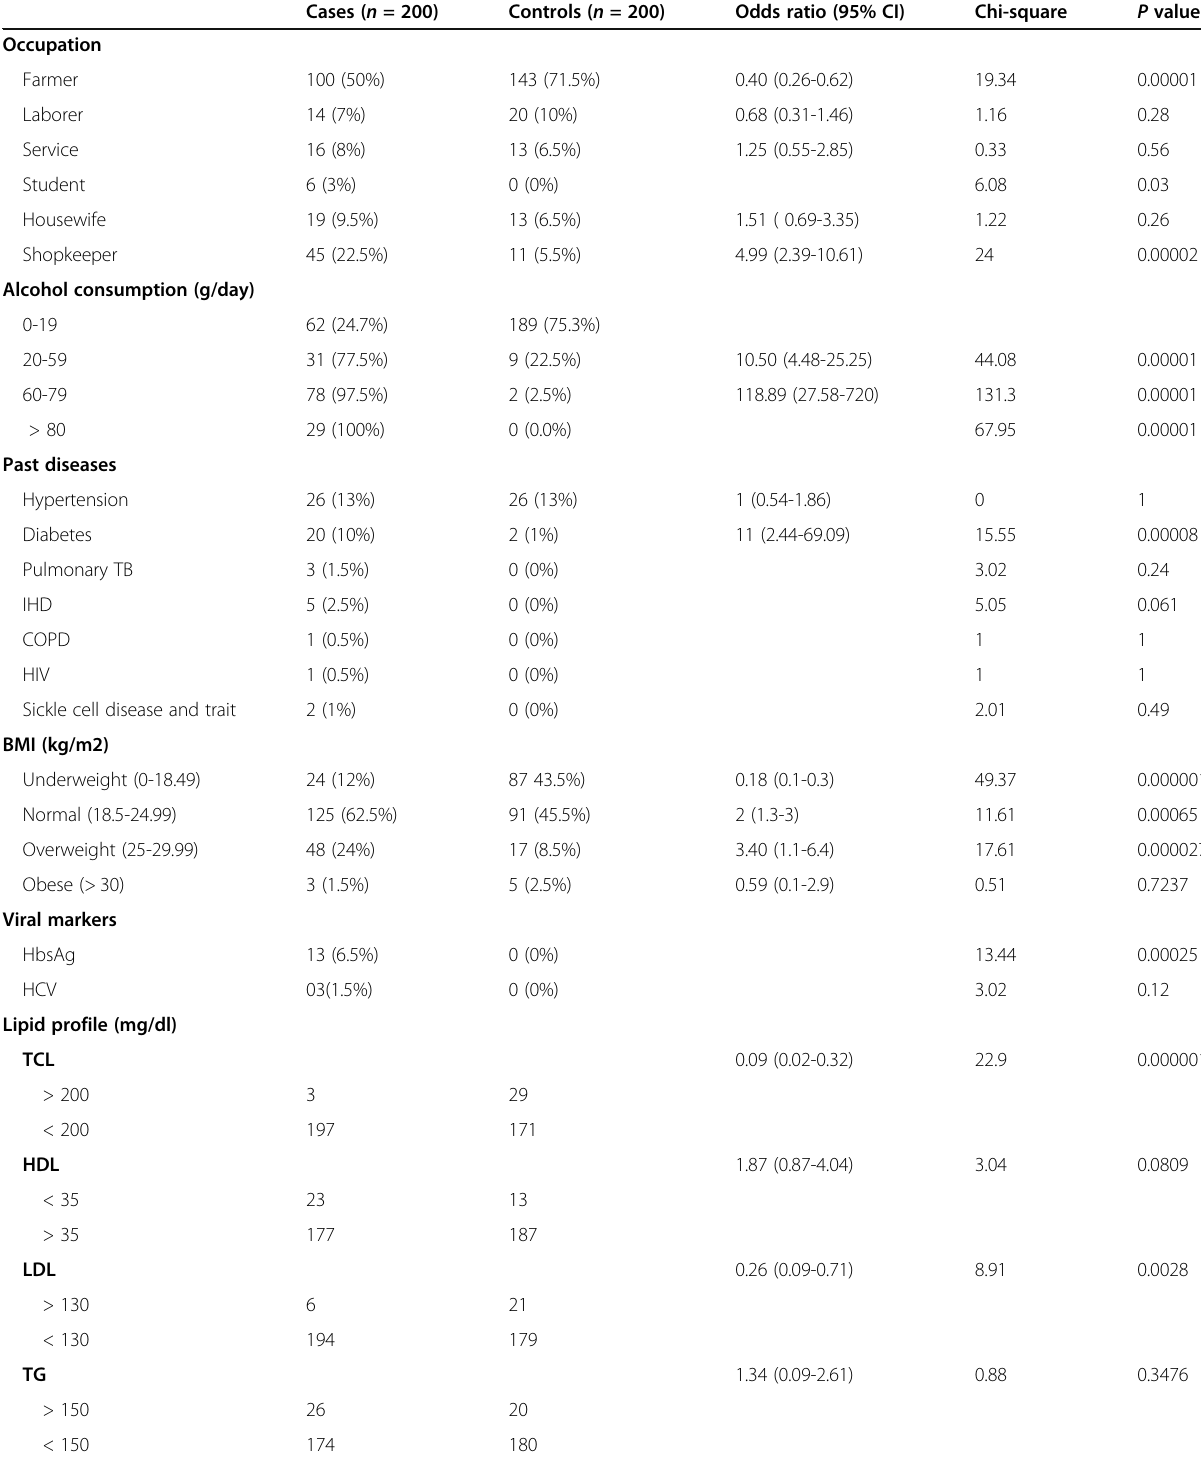
Table 2 Univariate analysis of risk factors for chronic liver